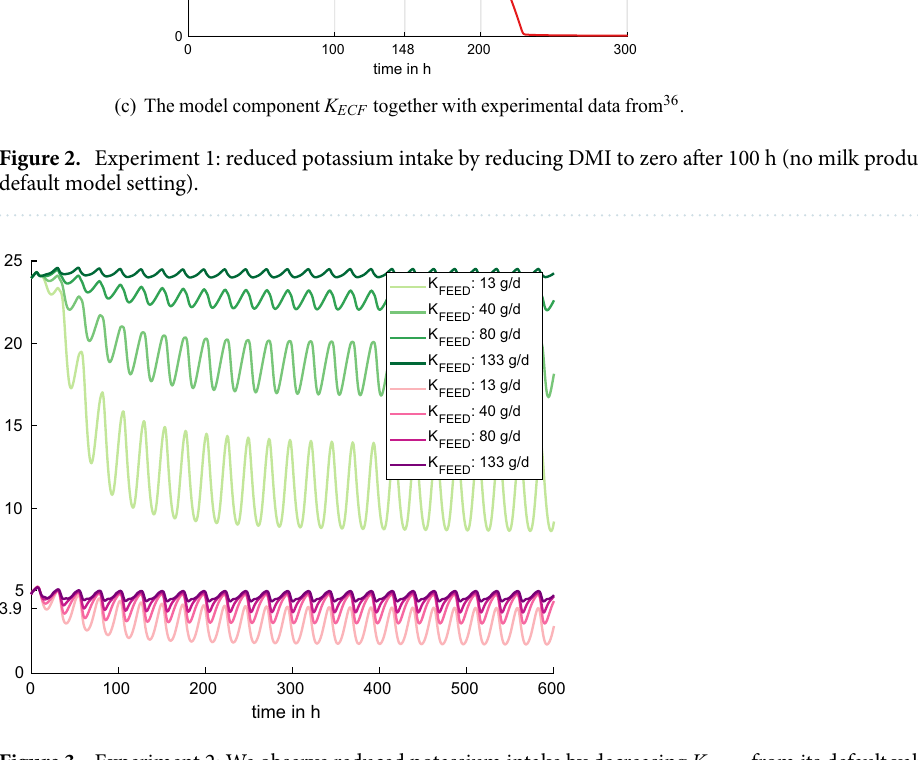
Figure 3. Experiment 2: We observe reduced potassium intake by decreasing K FEED from its default value of 133 g/day to 13 g/day. With decreasing K FEED , K ECF (pink, in mmol/L) and K ICF (green, in mmol/L) decrease as well. For the lowest experimental value K FEED = 13 g/day, hypokalemia occurs after 35